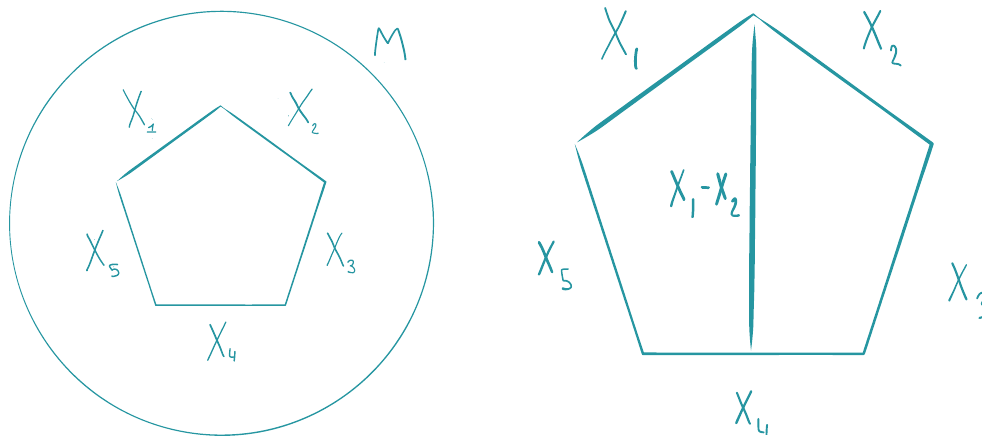
Figure 1 . A pentagon with the line at infinity { M = 0 } (left) and its decomposition into two squares